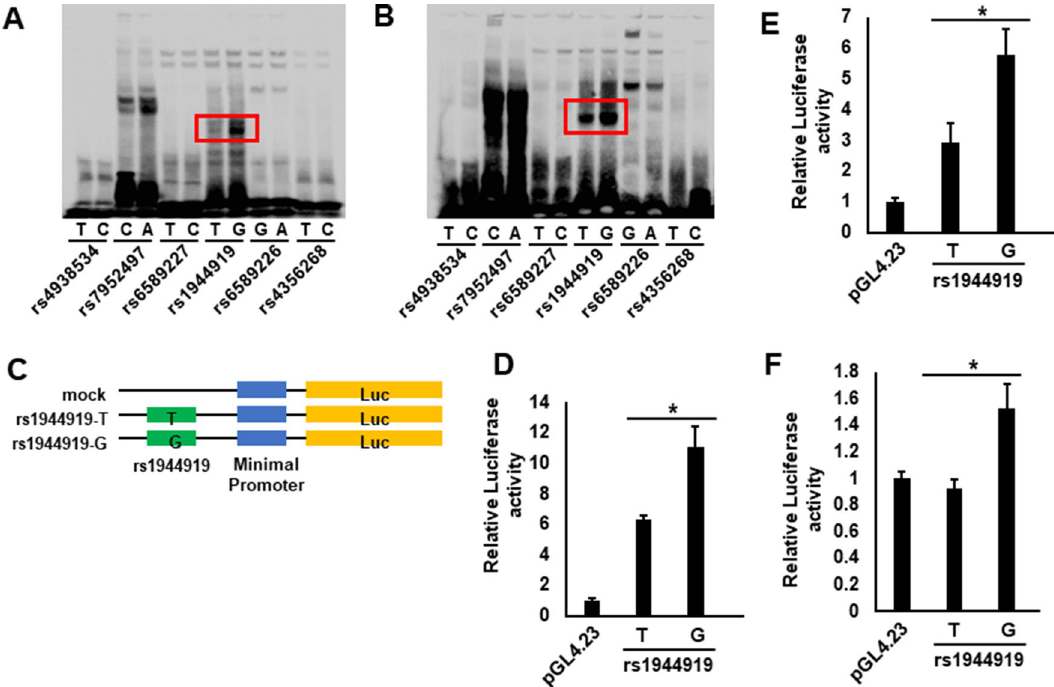
Figure 1. Identification of primary functional variants from candidate SNPs. ( A,B ) EMSA of each of the six candidate SNPs using biotin-labeled probes corresponding to major and minor alleles and nuclear extracts of Jurkat ( A ) and HepG2 ( B ) cells. rs1944919 was the only variant to exhibit a difference in mobility between the two alleles. ( C ) Outline of reporter plasmid constructs. PCR fragments containing rs1944919 were sub- cloned into the pGL4.23 vector. ( D–F ) Transcription was measured by cellular luciferase activity 24 h after transfection of Jurkat ( D ), HepG2 ( E ), and Raji ( F ) cells. The luciferase activity of cells transfected with